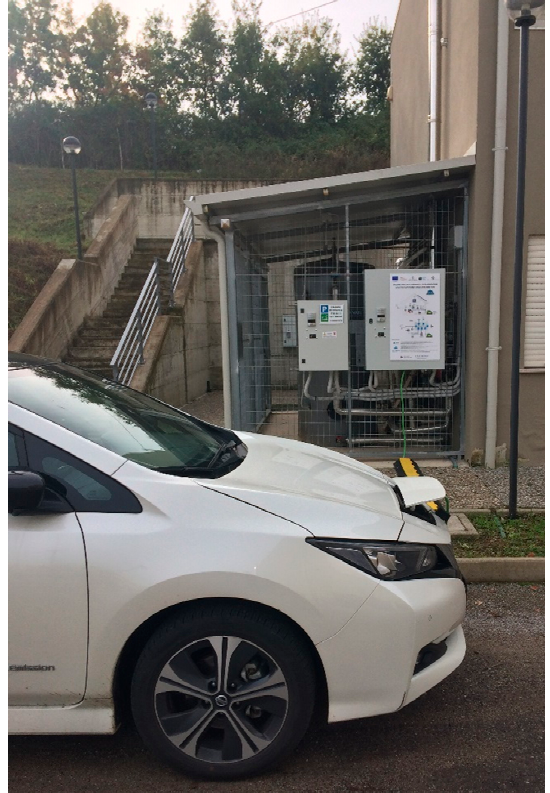
Figure 8. A Nissan Leaf during a charging test.